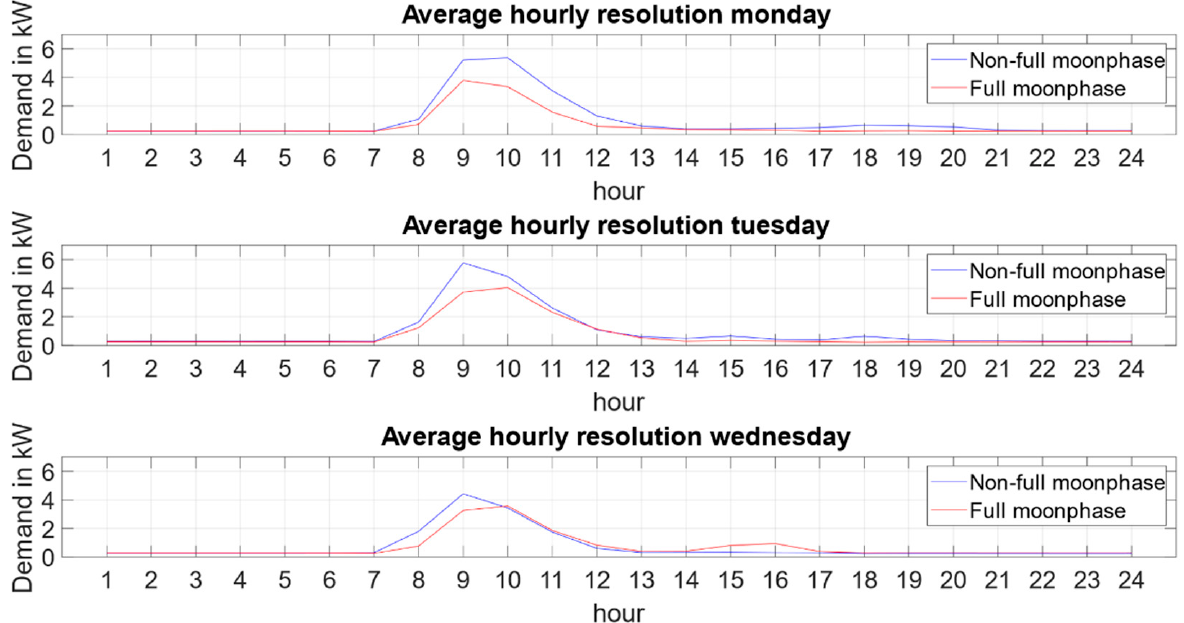
Figure 9. Average hourly electricity demand profile from the measurement during moon Figure 9 . Average hourly electricity demand profile from the measurement during moon phases.